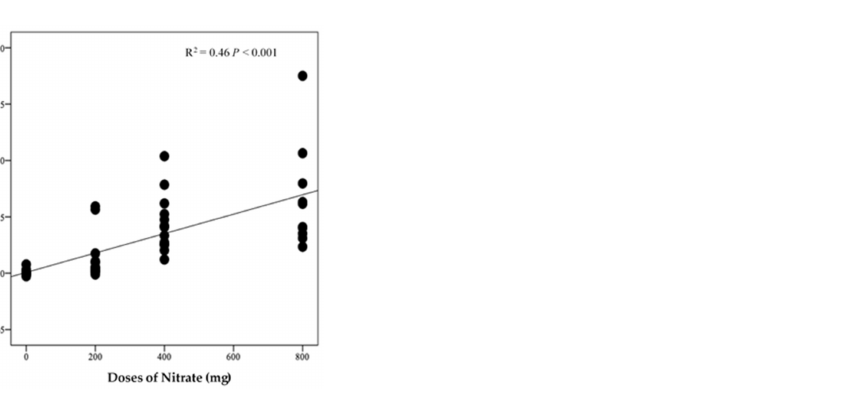
Figure 8. Linear relationship between the changes in urinary NO 3 − and doses of NO 3 − ( n =